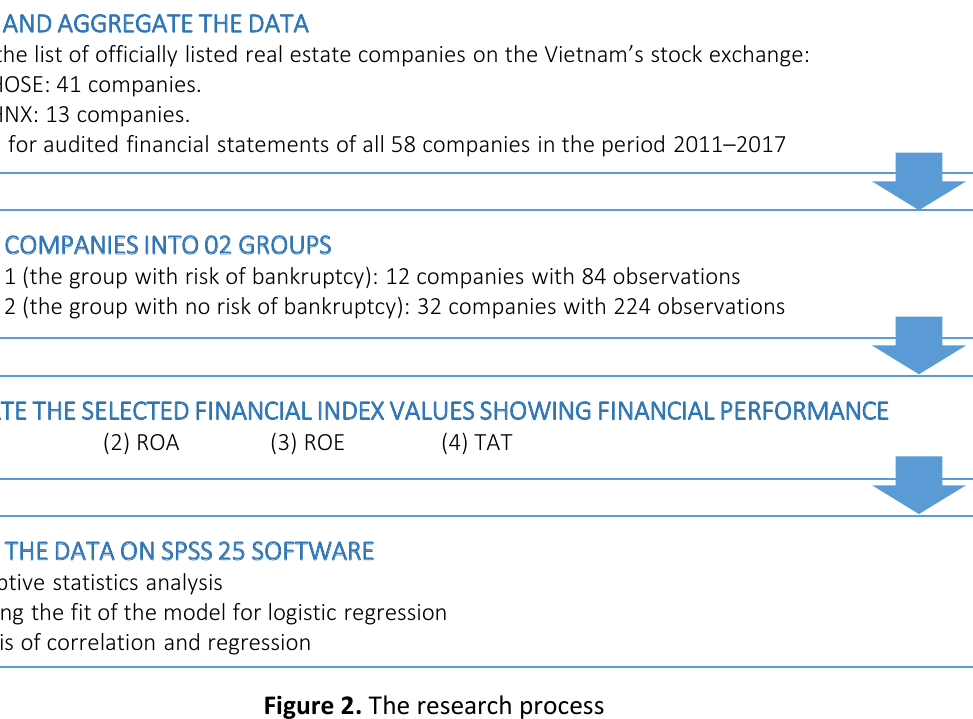
Figure 2. The research